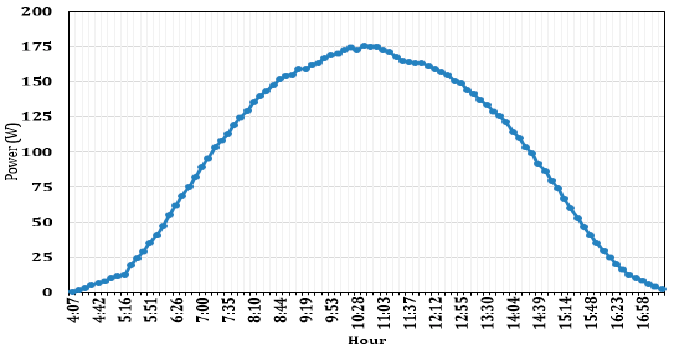
Figure 13. Power profile for one PV module.